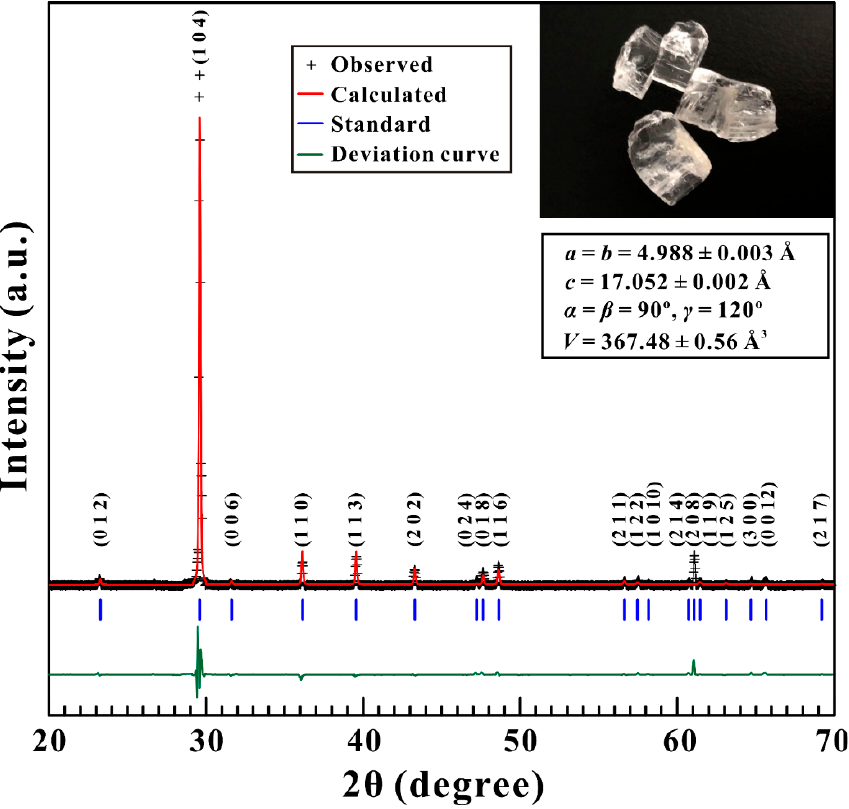
Figure 1. Powder X-ray diffraction (XRD) pattern and structural refinement for calcite at ambient conditions. The red solid line and the black crosses represent the calculated and observed results, respectively. The vertical blue bars stand for the standard peak positions of calcite. The green solid line denotes the deviation curve of measurement. Inset: the optical image of calcite.